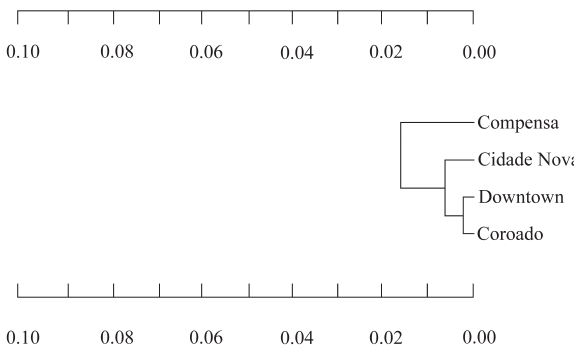
Figure 1 - Dendrogram resulting from grouping populations of Aedes aegypti on the basis genetic distance by the unweighted pairing group method which arithmetic mean - UPGMA (Nei,